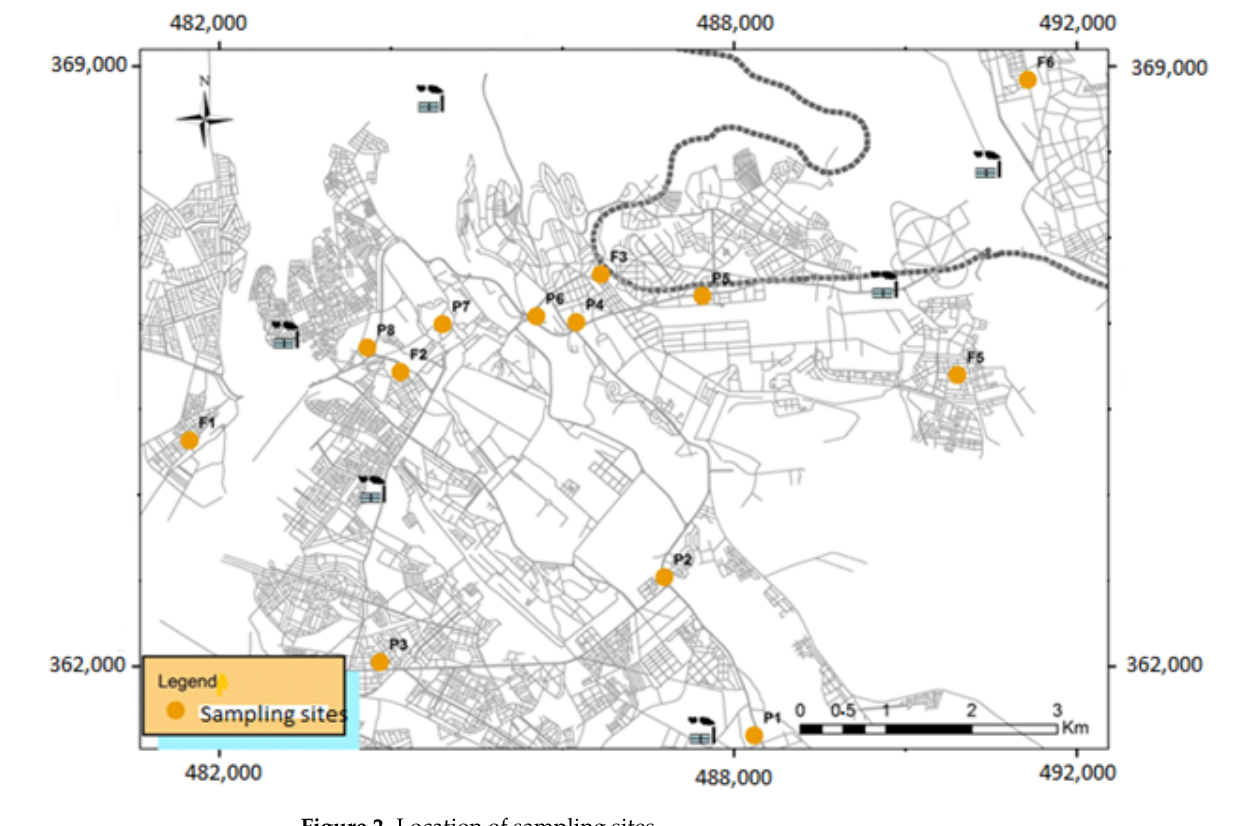
Figure 2. Location of sampling sites. Table 1. Distribution of sampling sites by type and location.